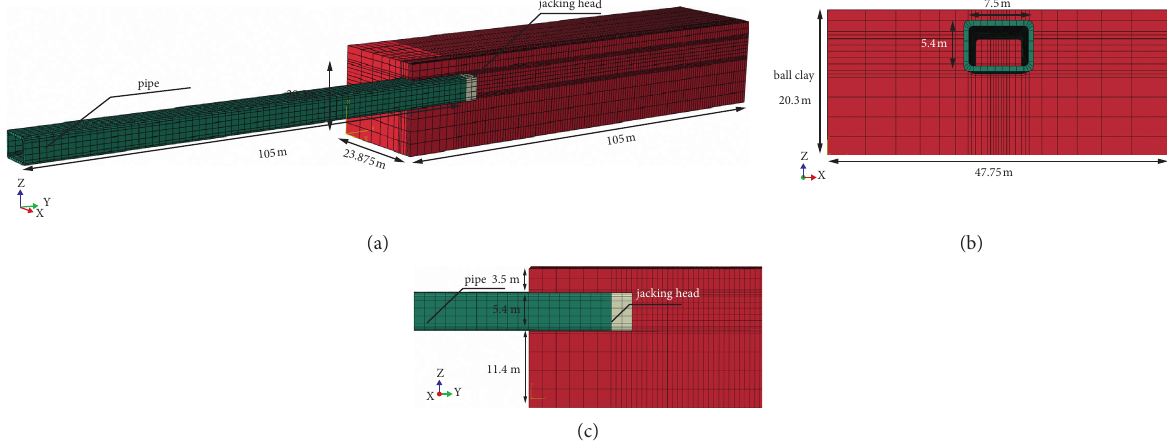
Figure 3: The finite element models of case A1. (a) Total. (b) Front view. (c) Side